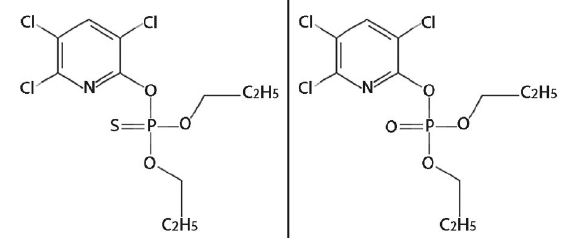
Figure 1 . O,O -diethyl- O -3,5,6-trichloro-2-pyridylphosphorothio- ate (CPS, left) and O,O -diethyl- O -3,5,6-trichloro-2-pyridylphos- phate (CPO,